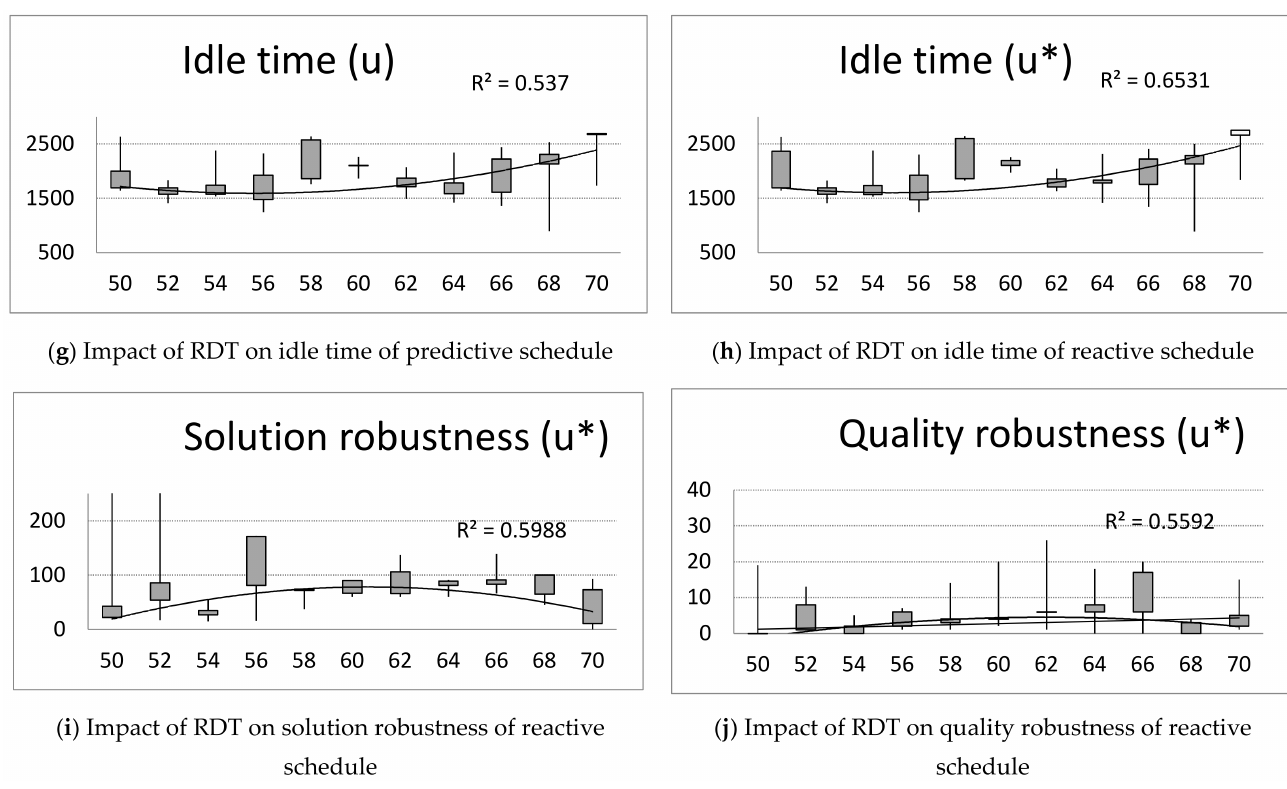
Figure 1. The impact of the FDM machine disturbance-free time RDT on predictive–reactive schedules assessed using the makespan C, total tardiness TD, flow time Y, idle time IT, solution robustness SR and quality robustness